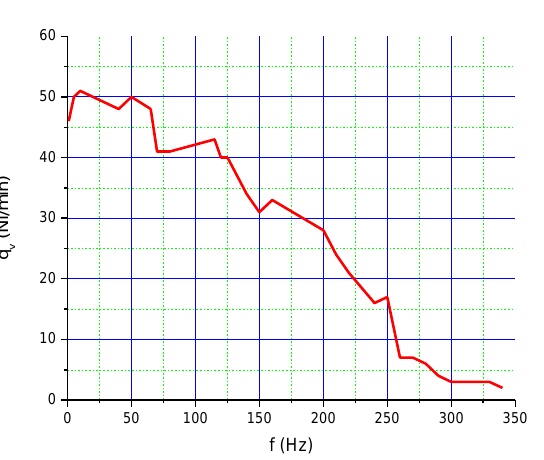
Fig. 11. Characteristic q BGEA-CTA.